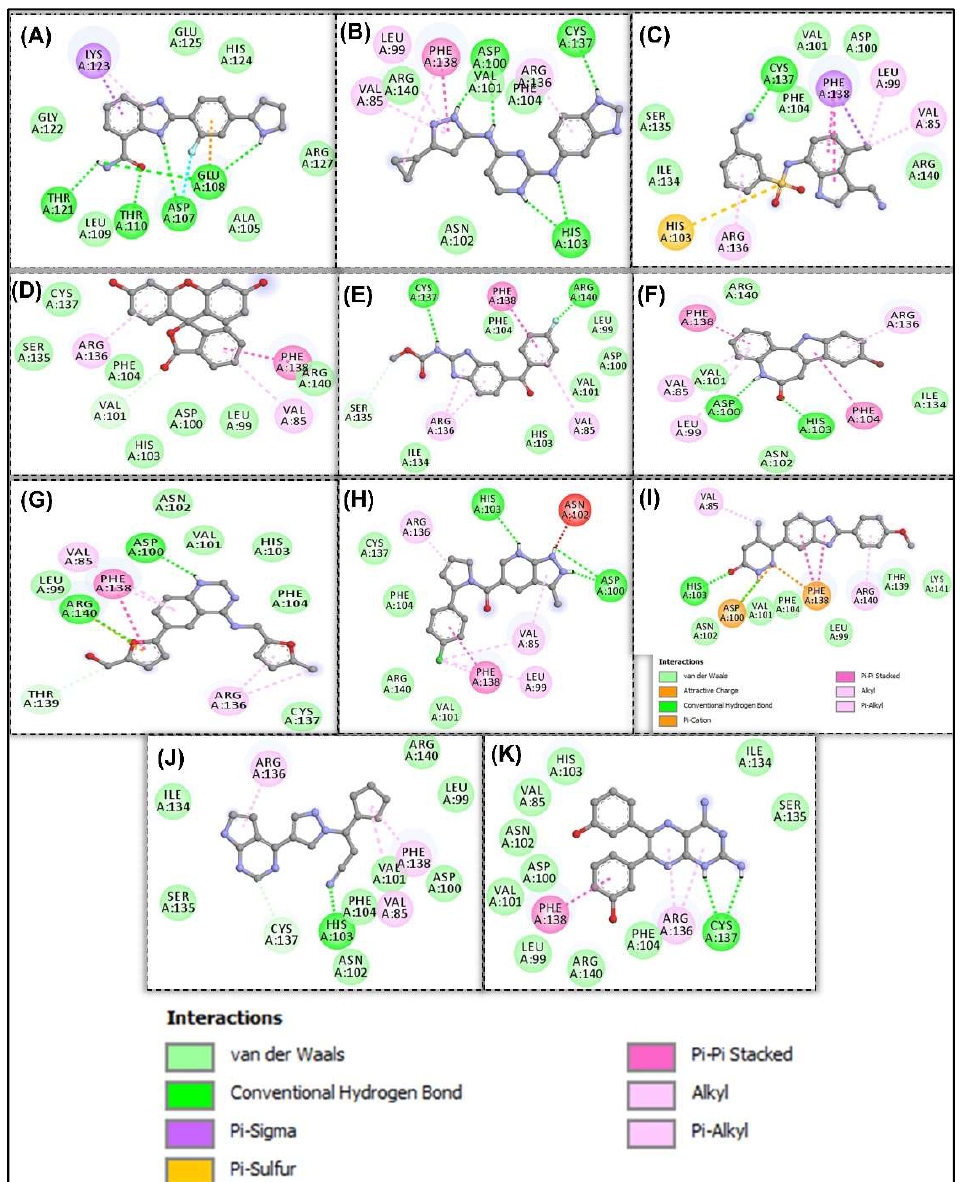
Figure 4. Molecular interaction of anti-cancer compounds docked against HSP27. 2D of anti-cancer compounds ( A ) A-966492 ( B ) APY29 ( C ) E7820 ( D ) Fluorescein ( E ) Flubendazole ( F ) Kenpaulline